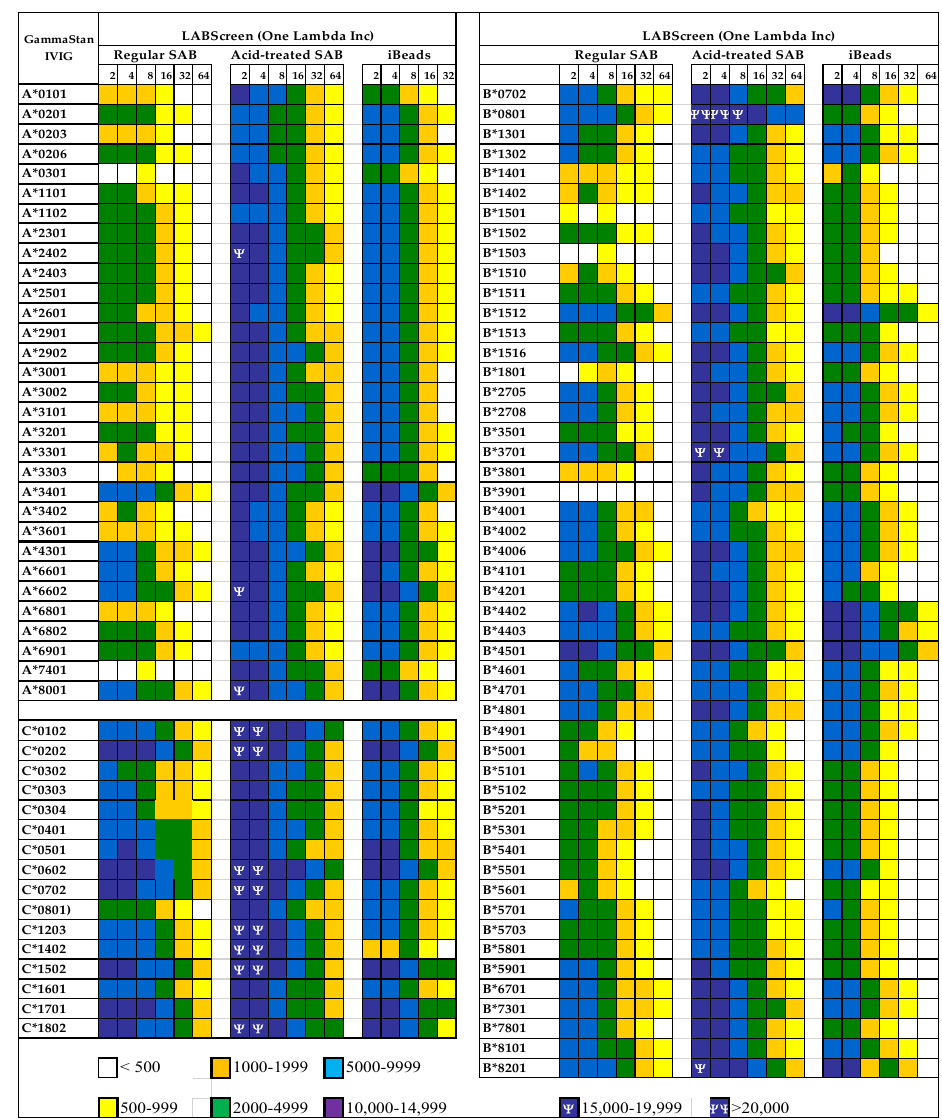
Figure 9. Documentation of antibodies against HLA class Ia molecules (HLA-A, HLA-B and HLA-C) in a commercial preparation (GamaStan) of Intravenous Immunoglobulin (IVIg). * Suggesting that the individuals may possibly carry naturally occurring antibodies formed against most com ‐ monly shared epitopes. The profiles of IgG antibodies were obtained on three different kinds of beadsets (LABScreen, One Lambda Inc, Canoga Park, CA). The different kinds of beads are (1) Reg ‐ ular LABScreen single antigen beadsets (SABs) which are coated with Face ‐ 1 admixed with Face ‐ 2 or open conformers, (2) the same SABs after mild acid treatment resulting in the exposure of cryptic epitopes, resulting in molecules similar to naturally occurring Face ‐ 2 on activated immune cells, (3) iBeads, the same regular LABScreen SABs which are gently trypsinized to remove Face ‐ 2, to leave only Face ‐ 1 on the solid matrix. The difference in the profile between regular beads and iBeads also illustrates the admixture of Face ‐ 1 and Face ‐ 2 in regular LABScreen SAB commonly used in the clinical laboratories. If the objective of the clinicians is to monitor antibodies against Face ‐ 1, then only iBeads or Immucor Beadsets will serve the specific purpose. Mean Fluorescent Intensities (MFI) are indicated in different colors and symbols.